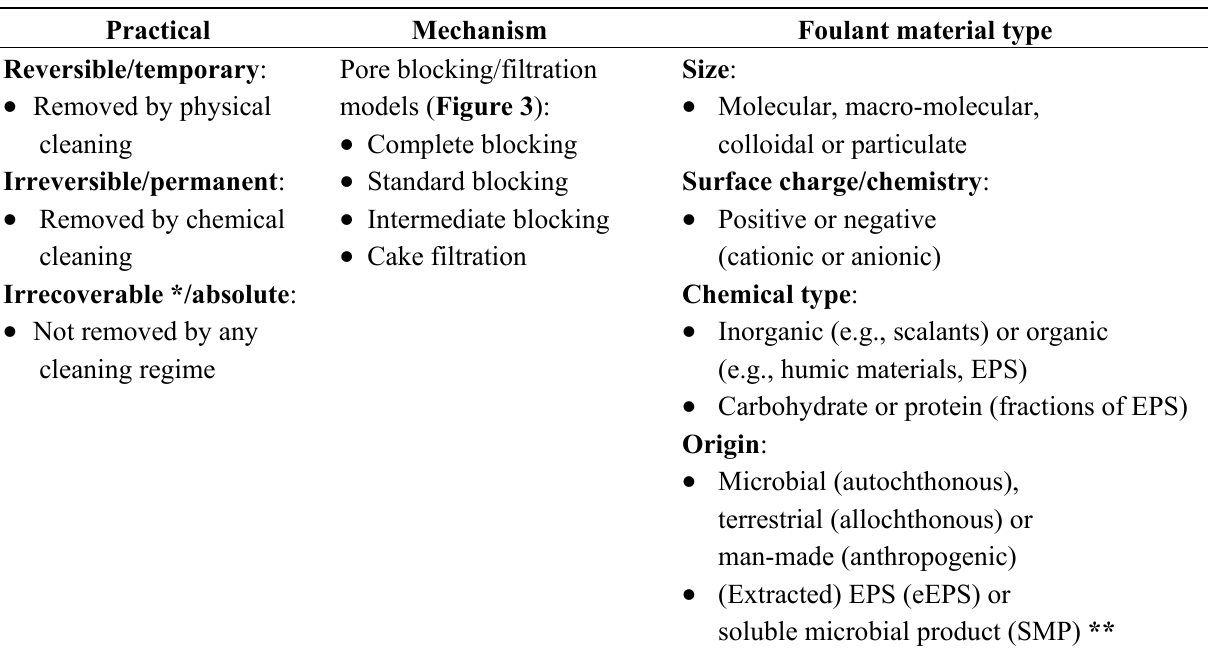
Table 1. Foulant definitions. Reproduced with permission from Reference